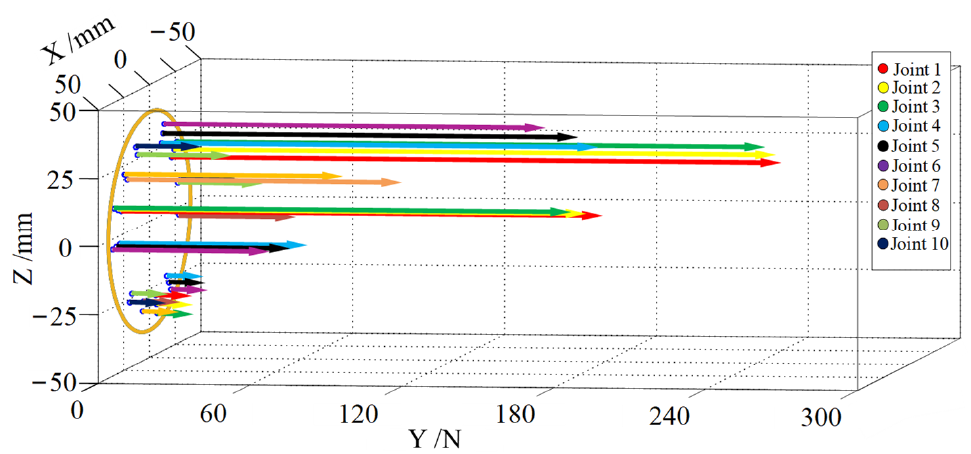
Figure 5. Traction force distribution of each cable in the initial pose.